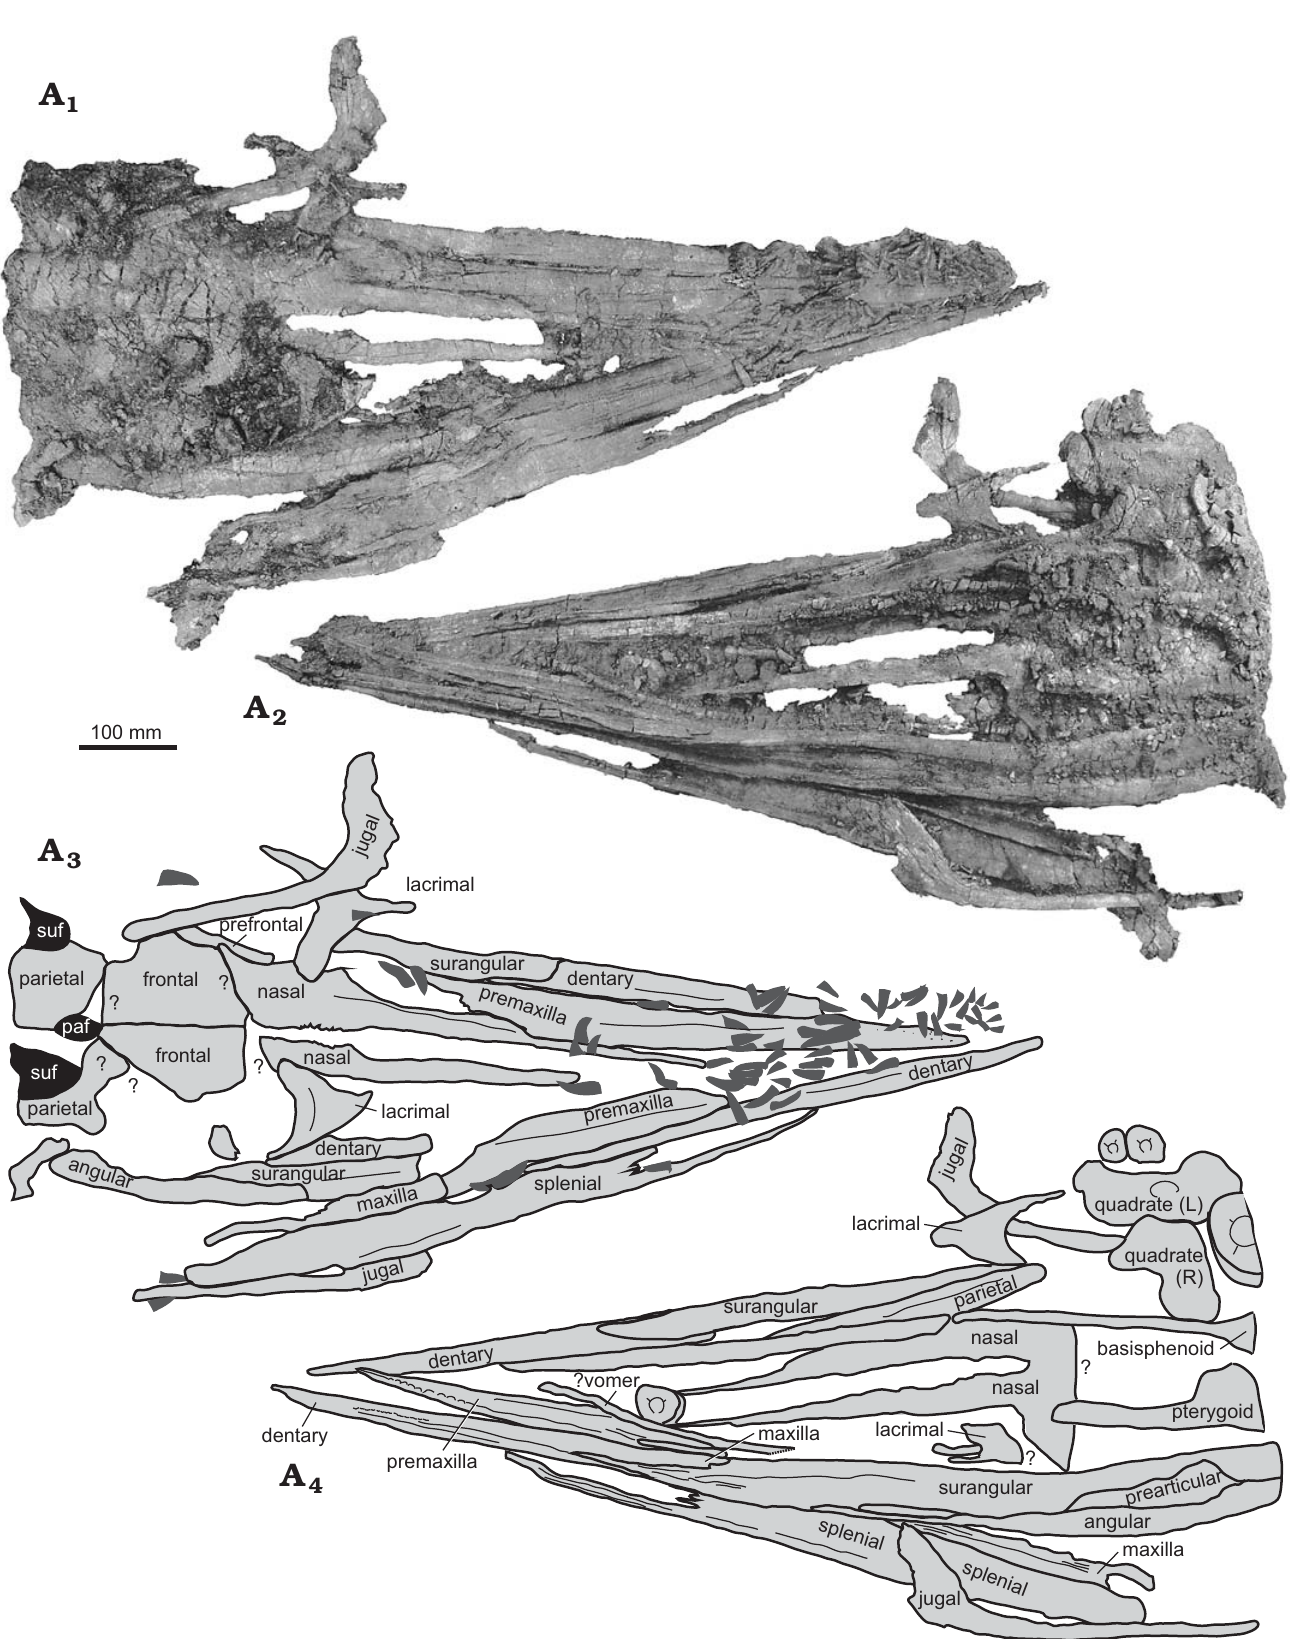
Fig. 8. Skull of Ophthalmosauridae indet. ( PMO 224.252) from Spitsbergen, Svalbard, Slottsmøya Member Lagerstätte, Tithonian; in dorsal (A 1 , A 3 ) and ventral (A 2 , A 4 ) views. Photographs (A 1 , A 2 ) and interpretative drawings (A 3 , A 4 ). L, left; R, right; paf, parietal foramen; suf, supratemporal